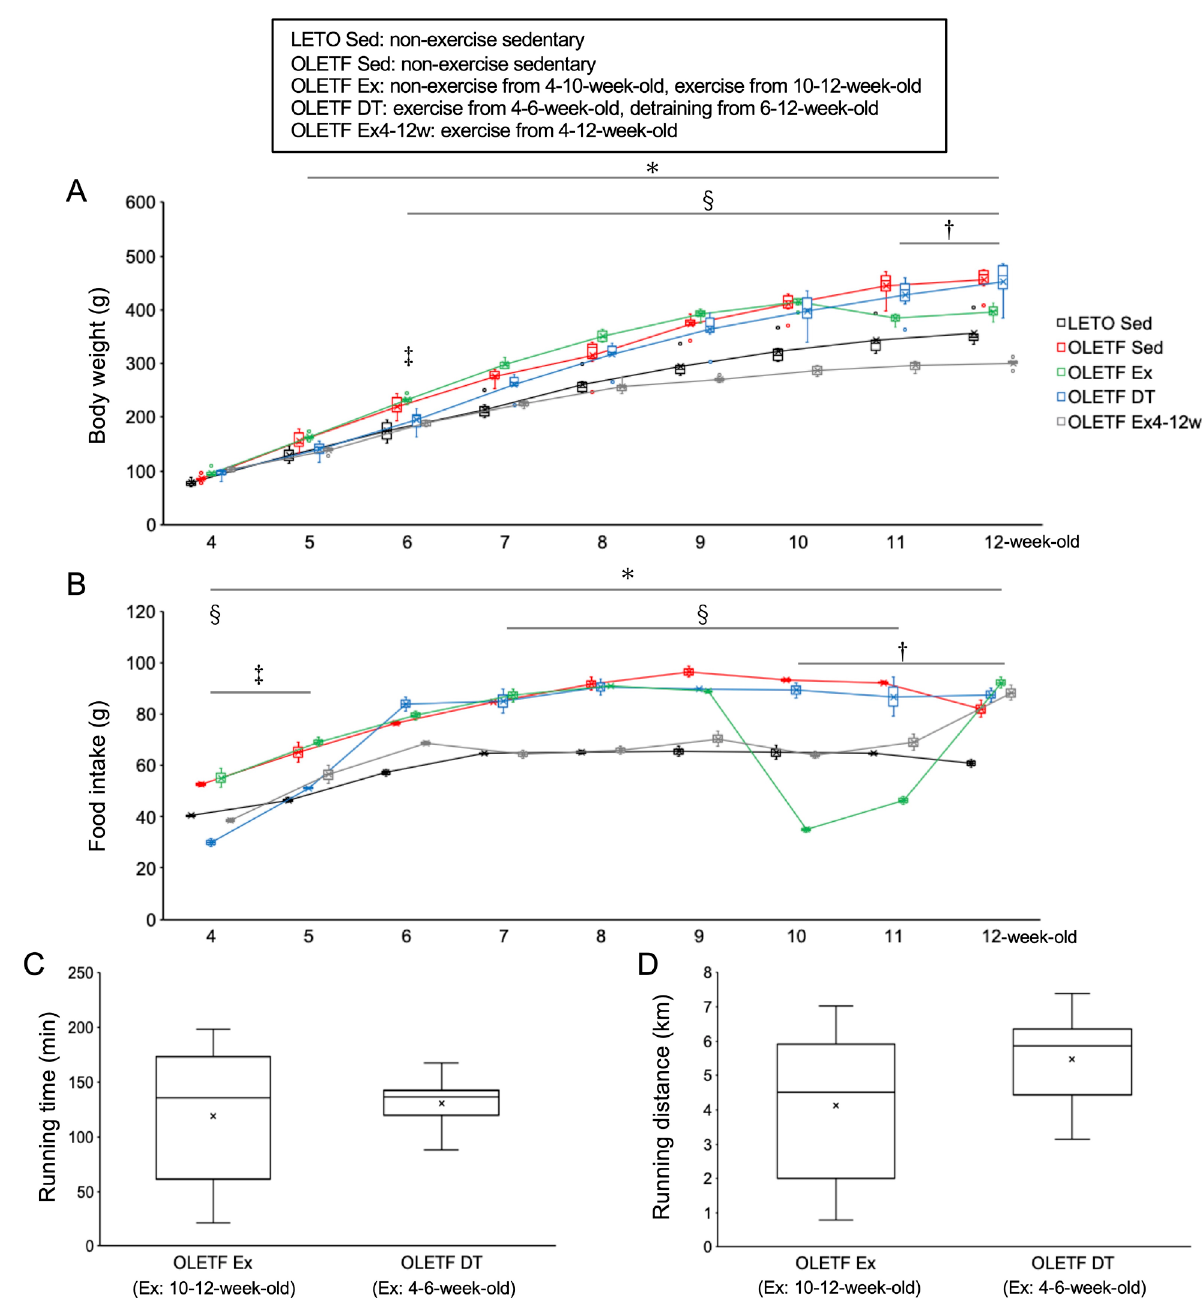
Figure 1. Metabolic characteristics. ( A ) changes in body weight; ( B ) daily food intake (per three rats in a cage); ( C ) daily running time; ( D ) daily running distance. LETO, Long-Evans Tokushima Otsuka rat; OLETF, Otsuka Long-Evans Tokushima Fatty rat. LETO Sed, LETO non-exercise sedentary; OLETF Sed, OLETF non-exercise sedentary; OLETF Ex, OLETF non-exercise from 4- to 10-weeks-old and exercise from 10- to 12-weeks-old; OLETF DT, OLETF exercise from 4- to 6-weeks-old and non-exercise detraining from 6- to 12-weeks-old; OLETF Ex4–12w, OLETF exercise from 4- to 12-weeks-old. Values represent means ± standard deviation. *, †, ‡, and § show significantly different between the OLETF Sed vs. LETO Sed groups, the OLETF Ex vs. OLETF Sed groups, the OLETF DT vs. OLETF Sed groups, and the OLETF Ex4–12w vs. OLETF Sed groups, respectively, p < 0.05.